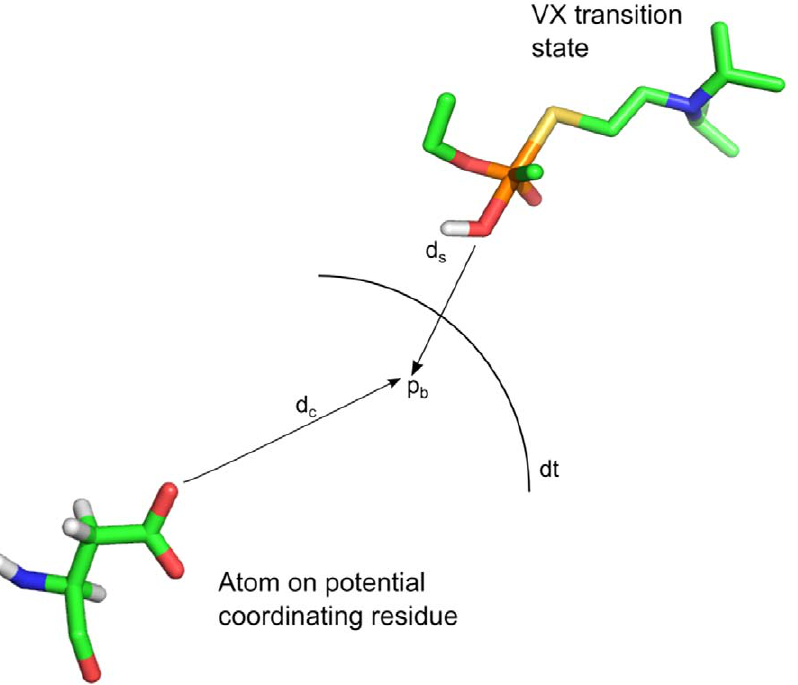
Figure 1. The clustering method used to group conformations by reaction mechanism. The two main parameters, d s and d t are shown.